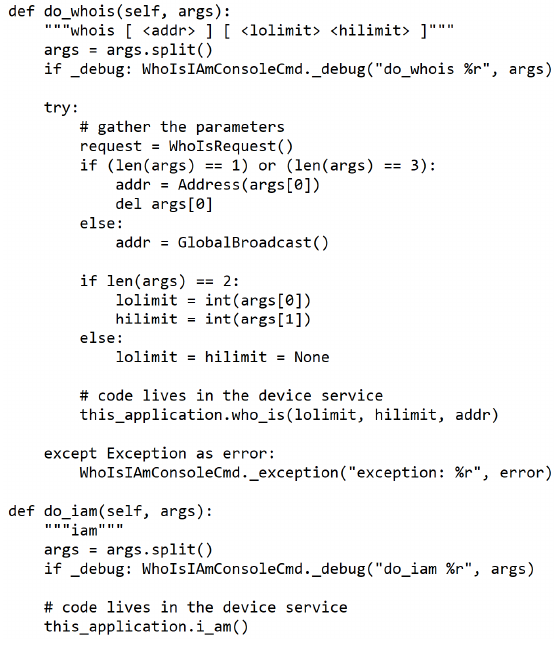
Figure 10. Send and reponed the request between two devices.